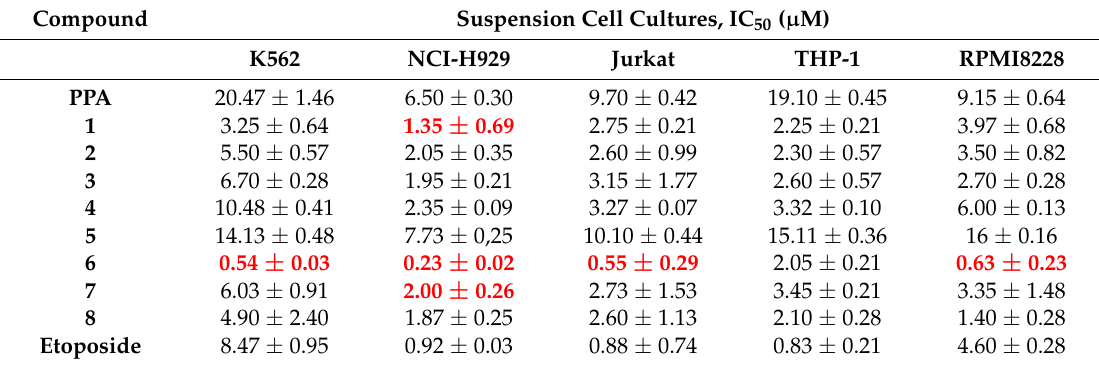
Table 2. IC 50 values for the respective compounds when studied on the suspension cell lines. Data were expressed as inhibitory ratio ± SD based on three independent experiments ( n =